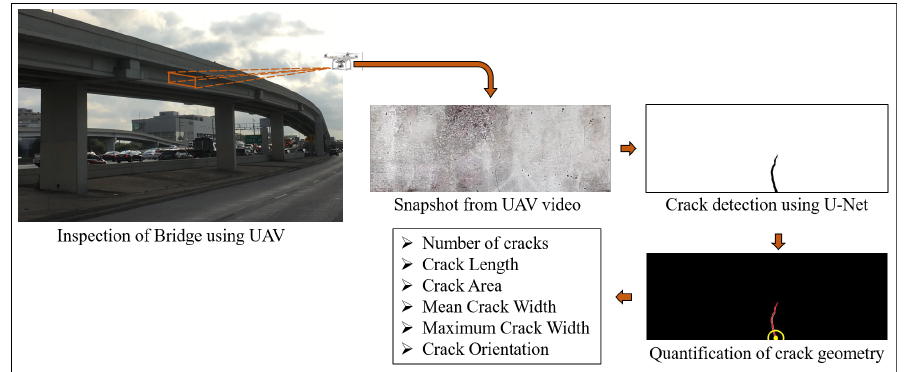
Figure 1. Outline of the proposed framework: Each frame of video acquired using the Unmanned Aerial Vehicle (UAV) is processed using U-Net to detect presence of crack at pixel level, which is further processed to obtain the geometric properties of the detected